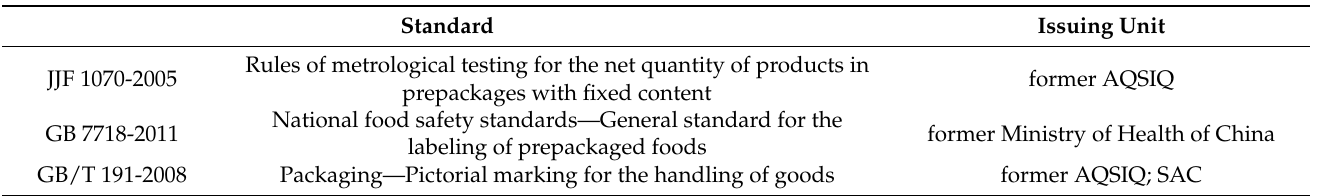
Table 5. National standards for net content and labeling of wine in China.